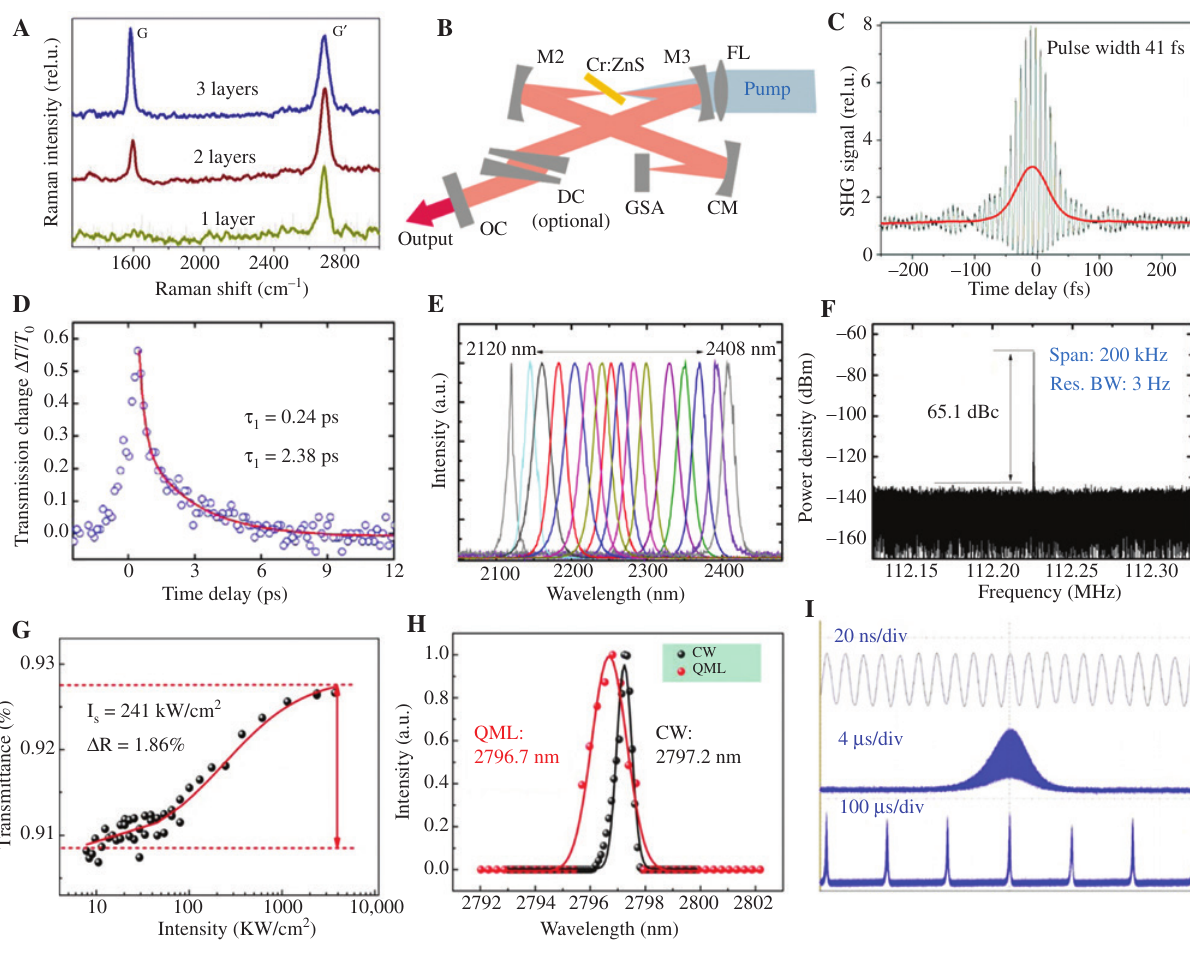
Figure 12: Grapheme mode-locked and MXene QML mid-infrared lasers. (A) Raman spectra with different layered graphene. (B) Schematic and (C) interferometric autocorrelation of the graphene mode-locked Cr:ZnS laser. Reproduced with permission [196]. Copyright 2014, Optical Society of America. (D) Degenerate pump-probe data; (E) tunable laser spectra and (F) frequency spectra of the graphene mode-locked Cr:ZnS laser. Reproduced with permission [195]. Copyright 2016, Optical Society of America. (G) Nonlinear transmittance of MXene Ti locked Er:Ca Sr F laser. Reproduced with permission [202]. Copyright 2019, IOP 0.8 0.2 2